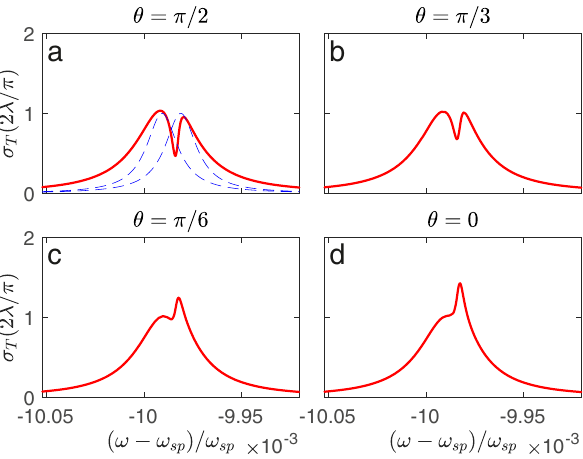
Figure 2: Scattering cross section of the system of two atoms coupled to the surface plasmon polariton (SPP) mode as shown in Figure 1, plotted as a function of frequency for different angles of incidence (plotted in red). The dotted blue curves show the (cid:19)(cid:19)(cid:19)(cid:19) (cid:19)(cid:19)(cid:19)(cid:19) (cid:19)(cid:19)(cid:19)(cid:19) (cid:19)(cid:19)(cid:19)(cid:19) 2 , 2 ) for the two individual scattering amplitudes ( b 0 , 1 b 0 , 2